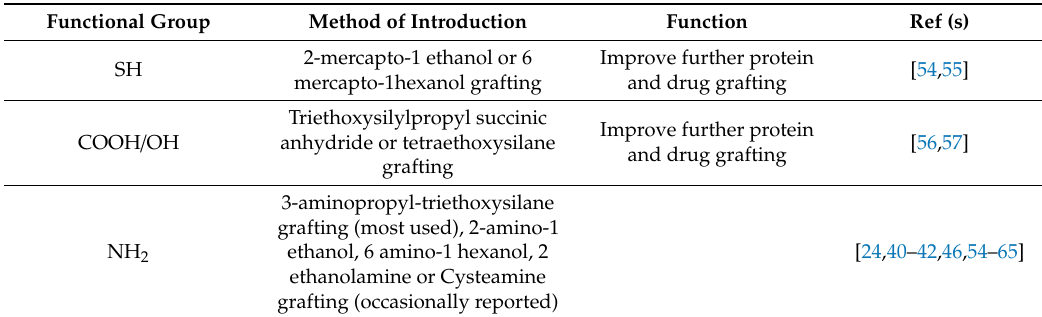
A summary of functional groups used to graft on the glasses and the subsequent biological